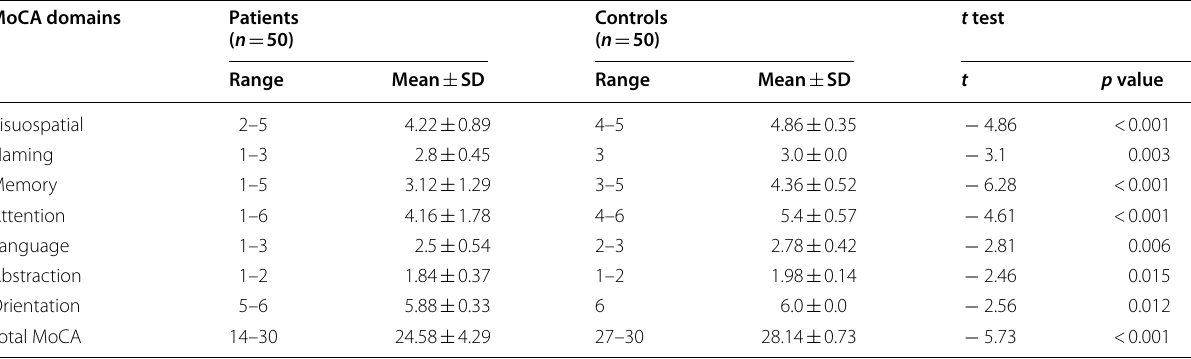
SD standard deviation